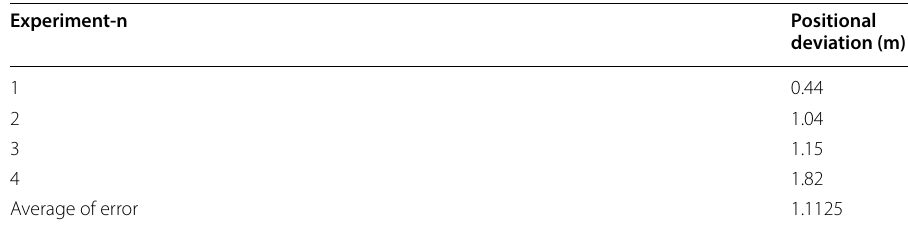
Table 1 Positional deviation from navigation algorithm Experiment-n